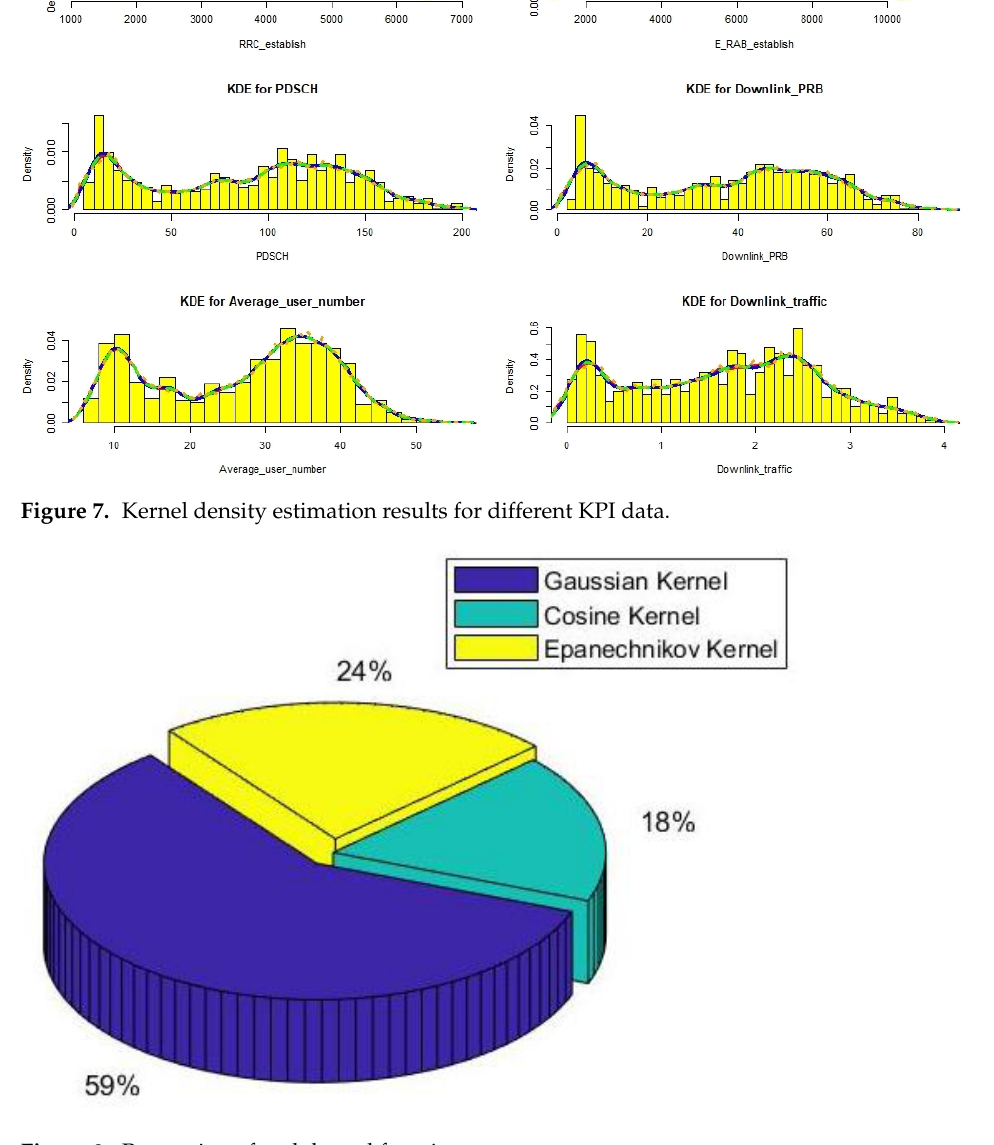
Figure 8. Proportion of each kernel